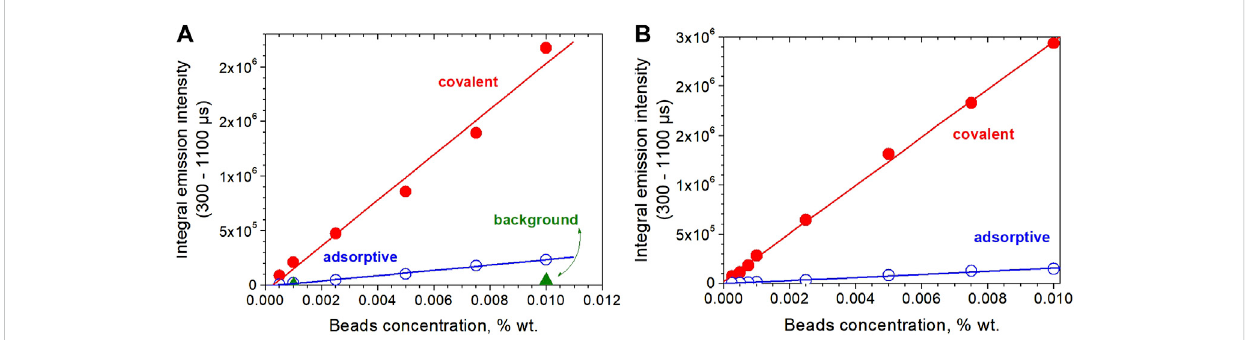
Time-gated luminescence intensity measurement of covalently and absorptively bead-coupled Neutravidin in biotinylated titerplates; volume added to vials was 200 µl. (A) Core-shell-beads from method 1 {[Eu(ttfa) 3 (TOPO) 2 /polystyrene/KPS] core [acrylic acid/methylmethacrylat/ACVA] shell )}; (B)